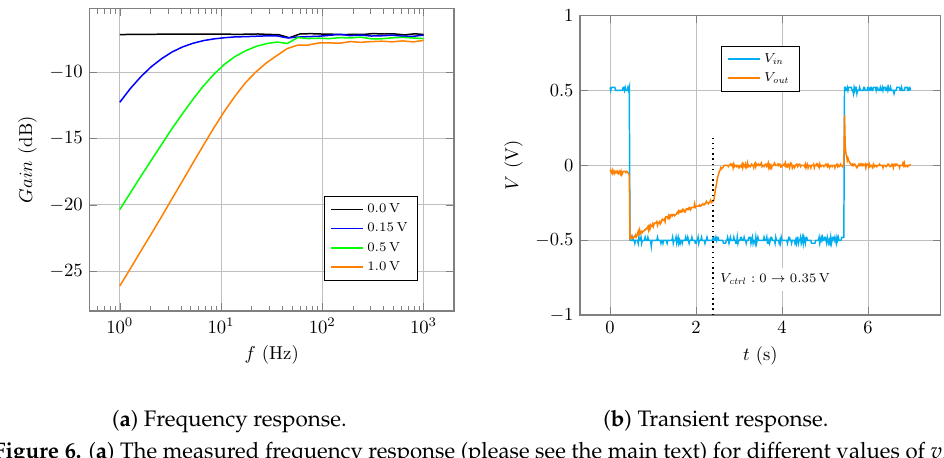
Figure 6. ( a ) The measured frequency response (please see the main text) for different values of v ctrl ; ( b ) transient response when v ctrl is changed abruptly from 0 to 0.35V at t = 2.5s. In the time domain, the behavior of the amplifier was checked by applying a pure differential square voltage to the amplifier input (cyan line in Figure 6b) with the feedback loop disabled ( v ctrl = 0); at a certain point in time, v ctrl is abruptly raised to a value of 0.35 V (not shown in the diagram; the switching instant is marked with a dotted vertical